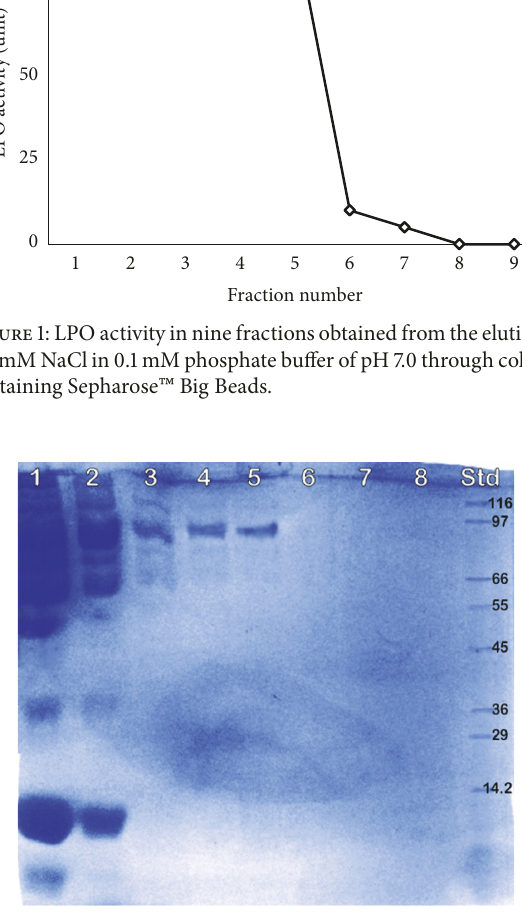
Figure 2: SDS-PAGE profile of nine fractions that were eluted from column packing Sepharose (cid:2) Big Beads. Lanes 1 to 8 were the samples from fractions 1 to